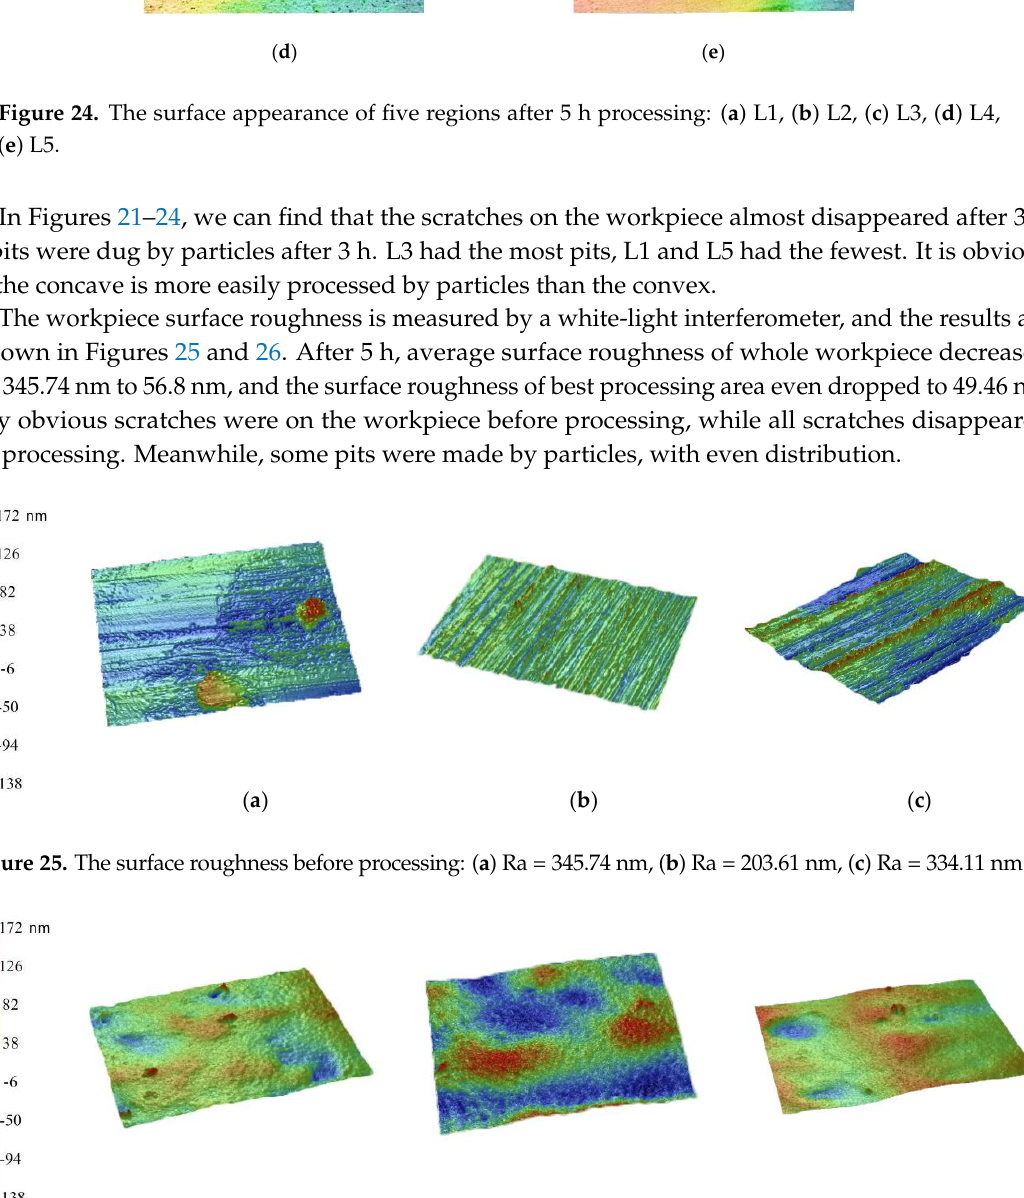
Figure 26. The surface roughness after processing: ( a ) Ra = 49.46, ( b ) Ra = 66.32, ( c ) Ra = 70.54.